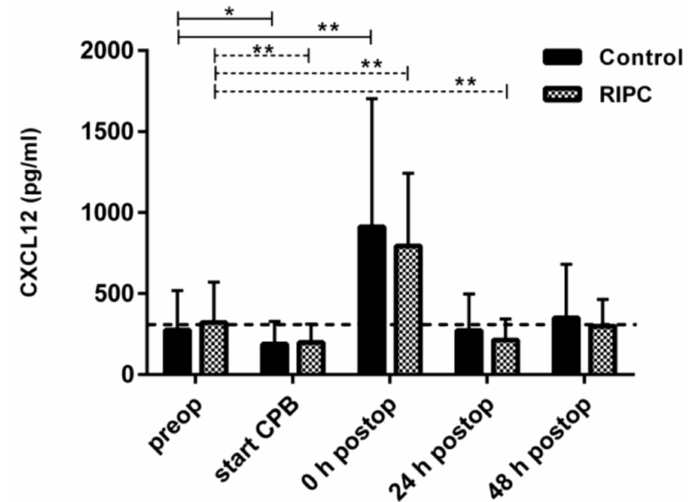
Figure 2. Secretion profile of proinflammatory cytokine, stromal cell-derived factor 1 (CXCL12), in control and remote ischemic preconditioning (RIPC) serum. Pre-, peri-, and postoperative concentrations of CXCL12 in serum samples assessed by ELISA. Data represents means ± SD; * p < 0.05; ** p < 0.01.